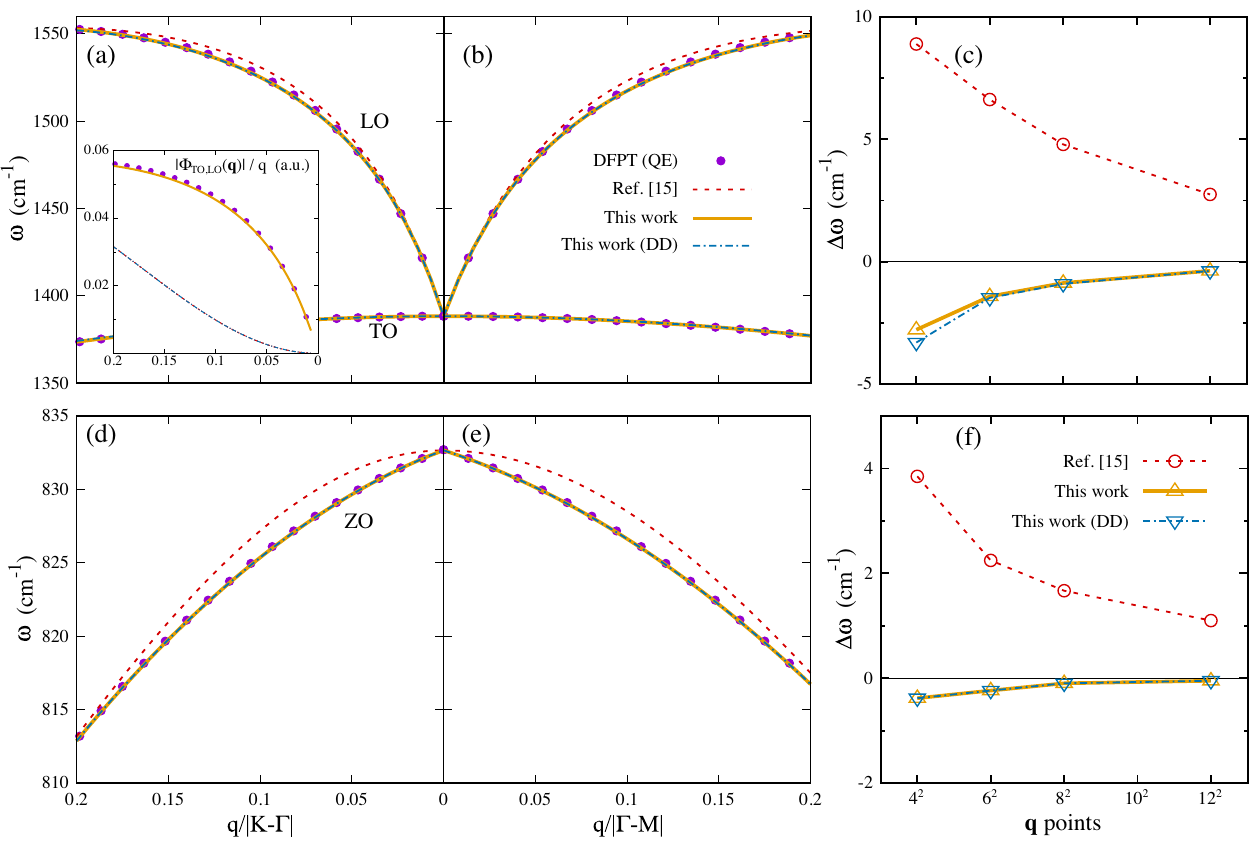
FIG. 5. BN. Dispersion of the LO, TO (a),(b), and ZO (d),(e) phonon branches in the long-wavelength limit along the K- Γ [(a) and (d)] and Γ -M [(b) and (e)] segments in the 2D Brillouin zone. The curves show the results of the 2D Fourier interpolation method in Ref. [15] as implemented in QE after having corrected the bug in the implementation (see the text) and of the method developed in this work, either with or without (DD) dynamical quadrupoles; exact [DFPT (QE)] phonon frequencies are shown as circles. All interpolations are performed on a grid of 8 × 8 in-plane q points. (c) and (f) show the absolute error resulting from the different interpolation methods as a function of the q -mesh density for the LO and ZO branches, respectively. DFPT frequencies are taken as reference, and the error is evaluated at the q point lying halfway between Γ and the first commensurate q point along the Γ -M segment. The inset in (a) shows the element of the Γ -mode representation of the force-constant matrix [Eq. (51)] that describes the coupling between the TO and LO modes along the K- Γ segment. Absolute values divided by the modulus of q are